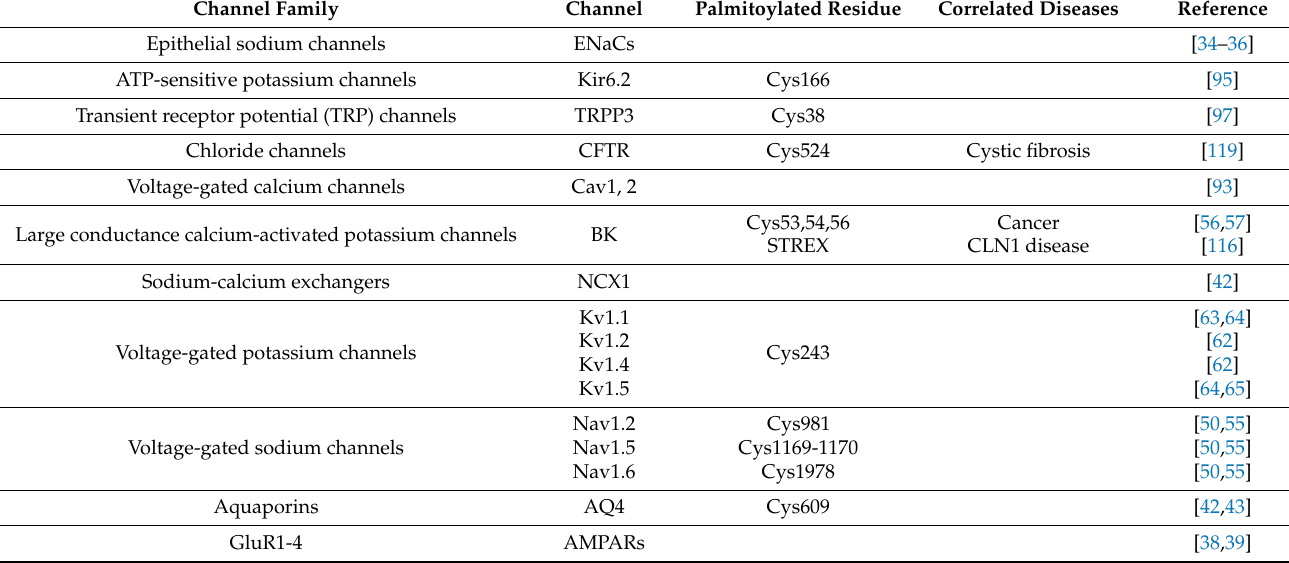
Table 1. Palmitoylated channels and correlated